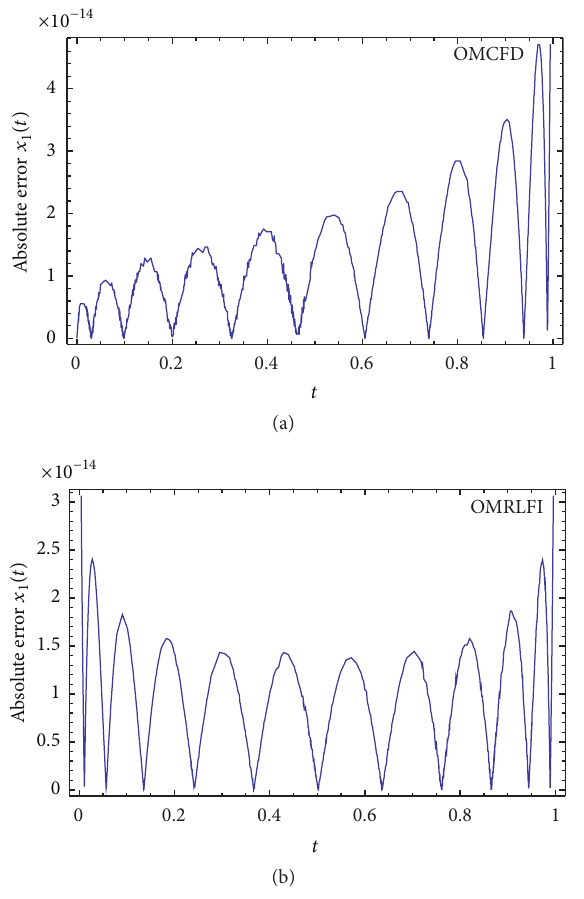
Figure 13: Plot of absolute error function 𝑥 2 (𝑡) for 𝛼 1 = 𝛼 2 = 𝛼 3 = 1 and 𝑚 = 10 by OMCFD and OMRLFI in Example